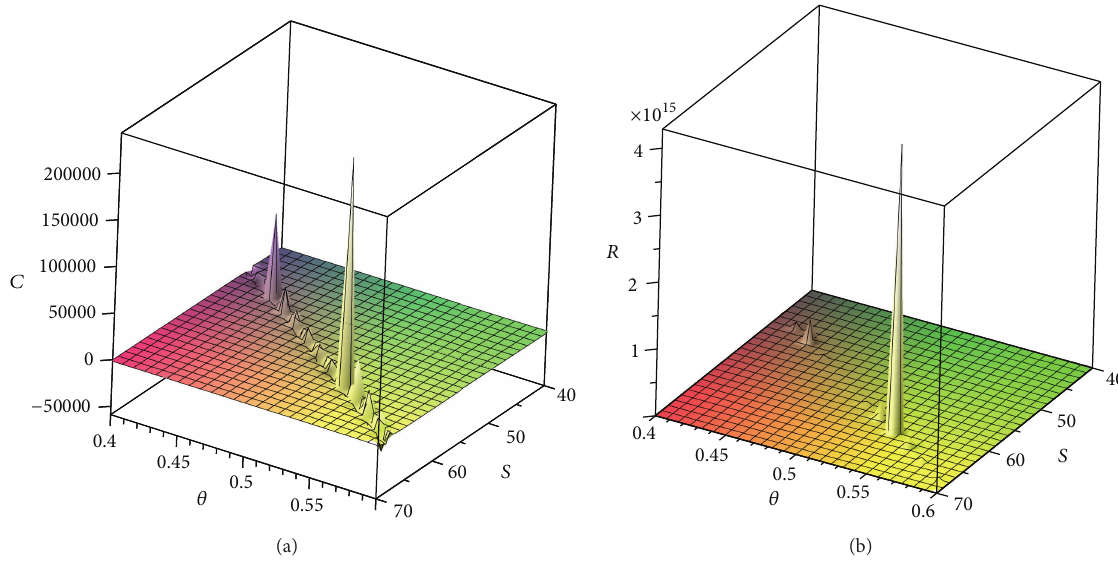
Figure 1: (a) Characteristic behaviour of the heat capacity as a function of 𝑆 and 𝜃 . (b) Characteristic behaviour of the thermodynamic curvature scalar 𝑅 as a function of 𝑆 and 𝜃 . Note that the singularities follow the same pattern in both functions, indicating the presence of phase transitions.